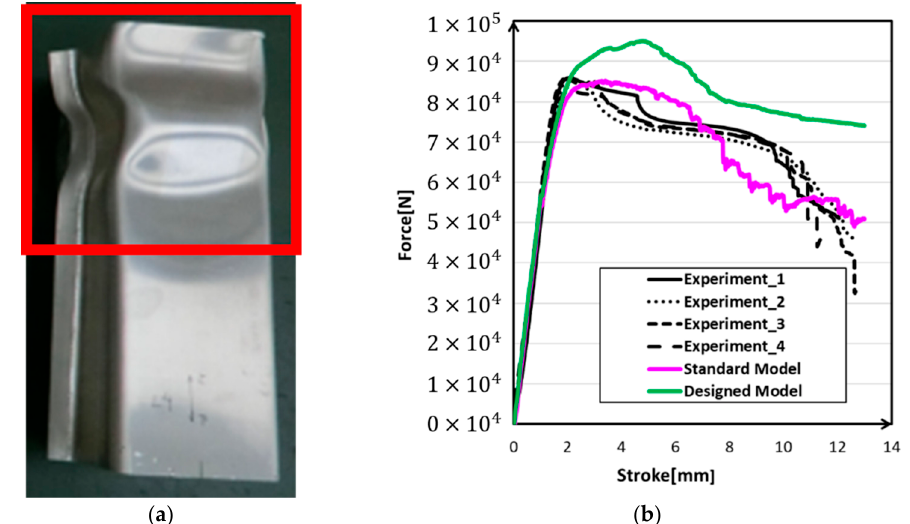
Figure 11. Effective plastic strain: ( a ) standard model; ( b ) designed model.